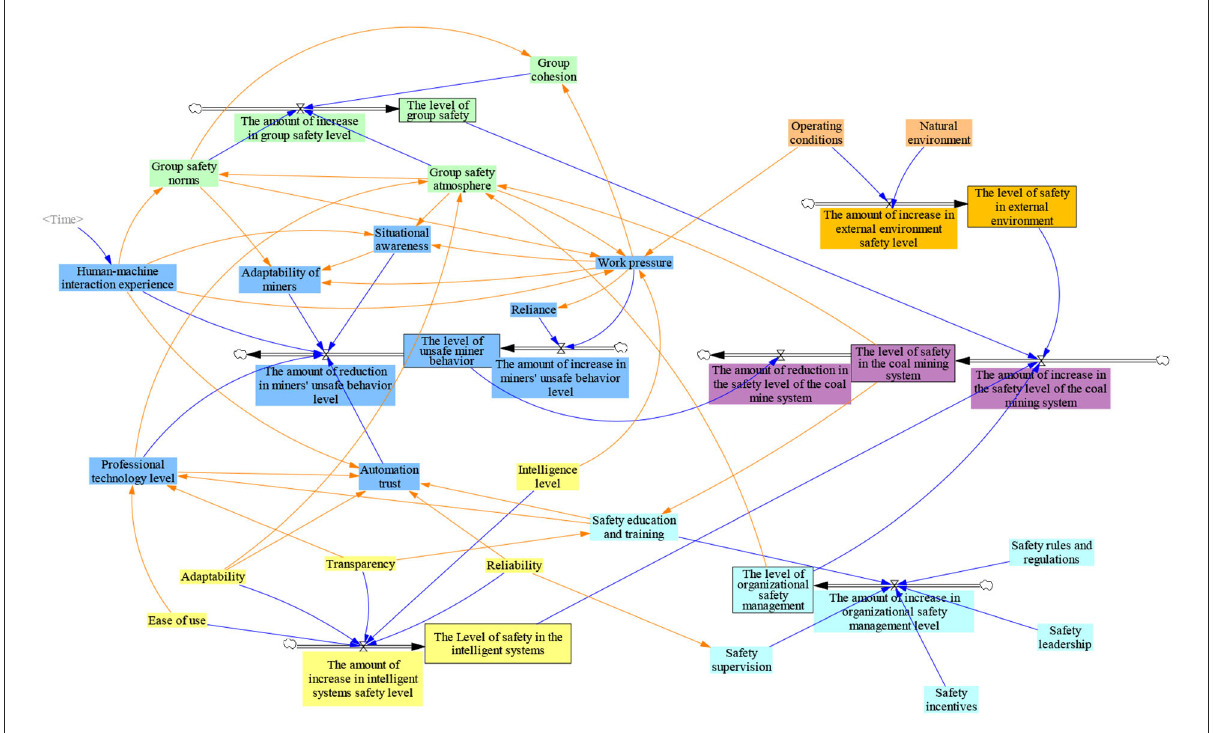
FIGURE6 Stock-flow diagram of coal mine safety system.